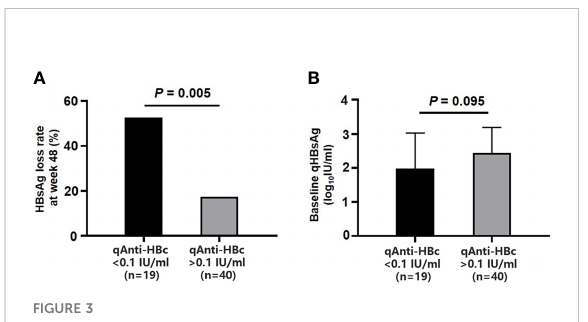
FIGURE 3 Comparison of HBsAg loss rates at week 48 and baseline qHBsAg in the add-on group with baseline qAnti-HBc <0.1 IU/ml and > 0.1 IU/ml. (A) Comparison of HBsAg loss rates at week 48 in two subgroups. (B) Comparison of baseline qHBsAg in two subgroups. HBsAg, hepatitis B surface antigen; qHBsAg, quantitative HBsAg; qAnti-HBc, quantitative anti-hepatitis B core